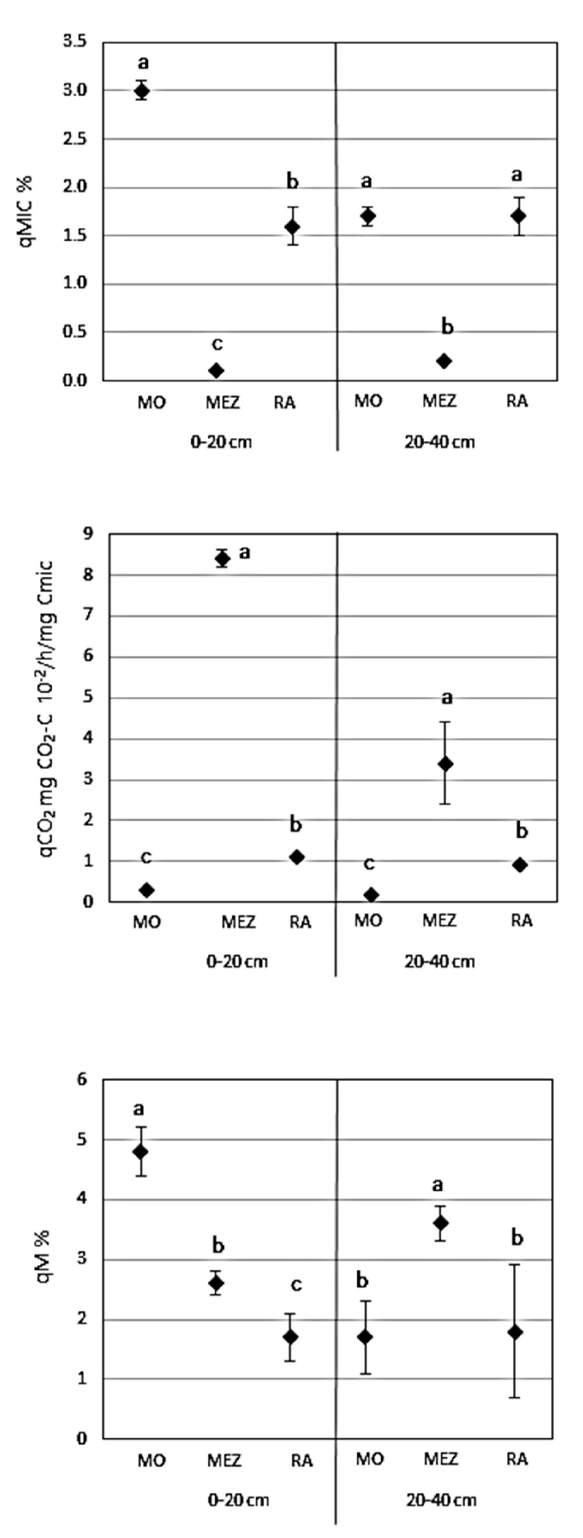
Figure 2. Microbial (qMIC), mineralization (qM) and metabolic (qCO 2 ) quotients and in 0–20 and 20–40 cm soil layers of processing tomato fields located in Modena (MO), Ferrara (MEZ) and Ravenna (RA) provinces, Emilia Romagna Region, Italy. Error bars represent standard error of the mean. Different letters mean significant differences (Kruskal–Wallis test, p < 0.05) among sites within 0–20 and 20–40 cm soil layers.